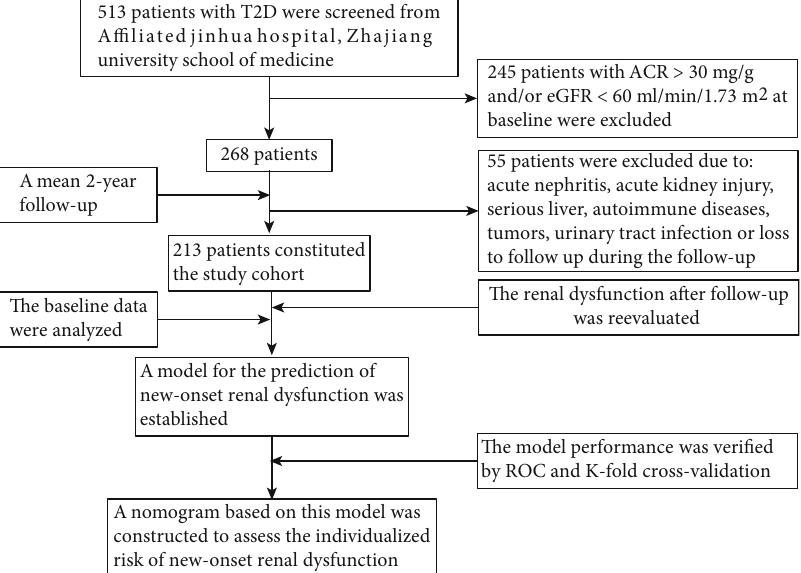
Figure 1: A fl owchart with study design and inclusion/noninclusion criteria. T2D: type 2 diabetes; ACR: albumin-to-creatinine ratio; eGFR: estimated glomerular fi ltration rate; ROC: receiver operating characteristic analysis. Table 1: The baseline characteristics of the participants included in this study.